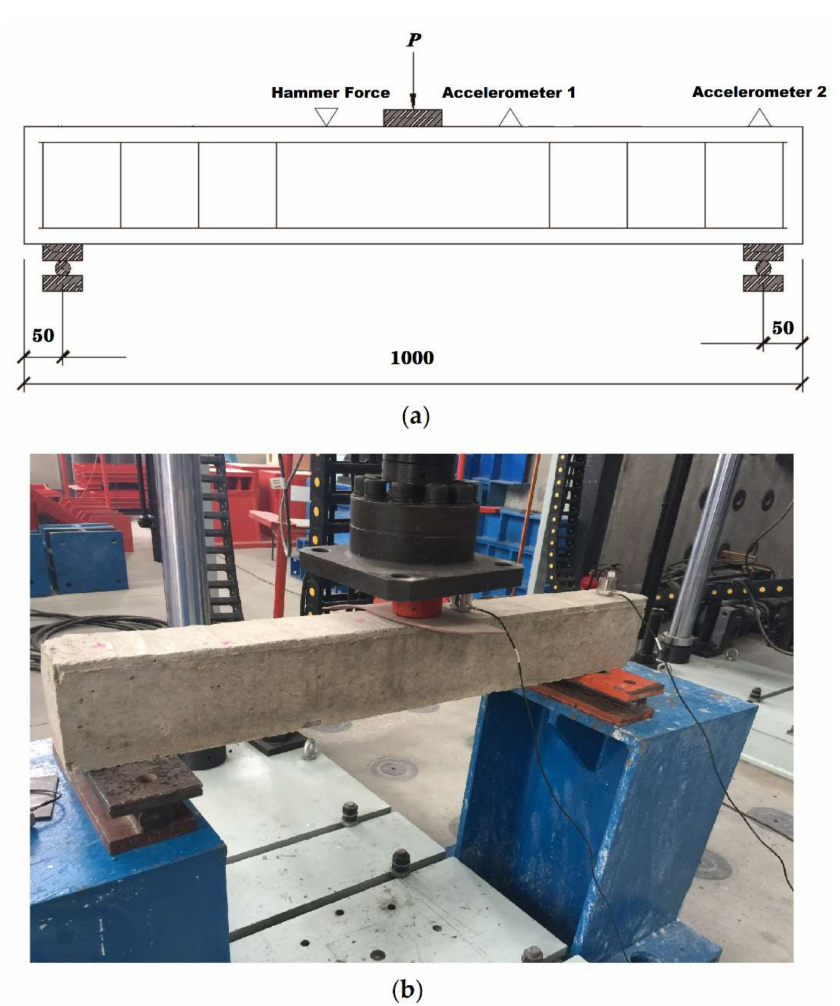
Figure 7. ( a ) Illustration of test setup with reinforced concrete beam and ( b ) photograph showing experimental setup. Dimensions in (mm).